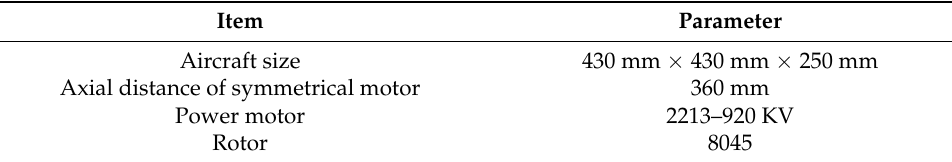
Figure 1. UAV model. Table 1. E360-S2 UAV parameters.